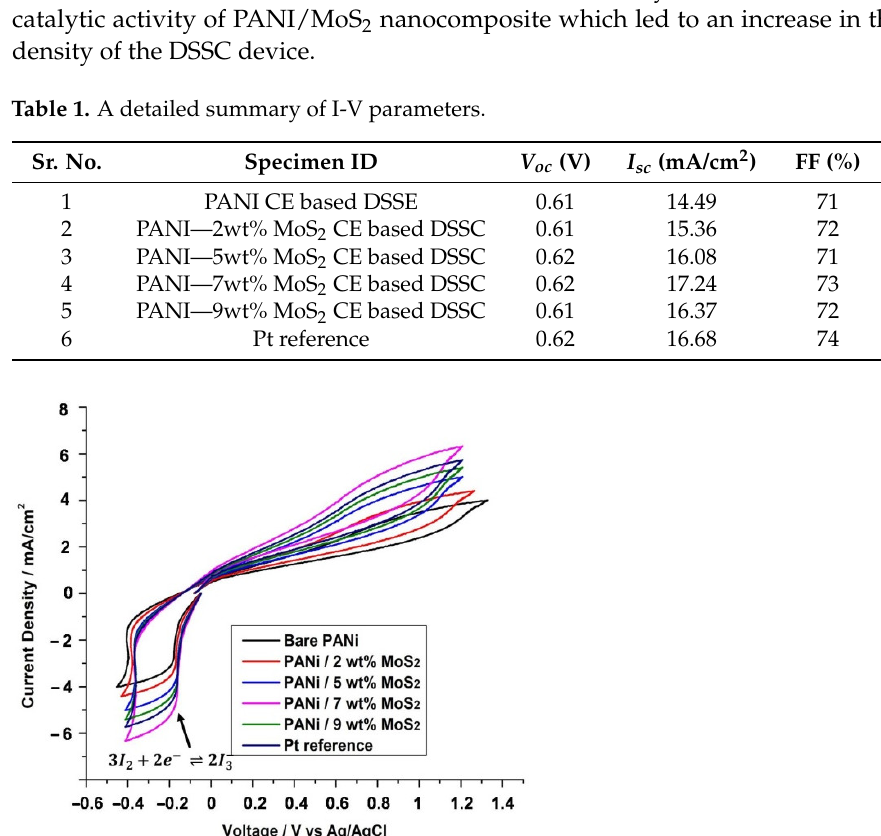
Figure 3. Current-voltage curves of specimens under investigation.